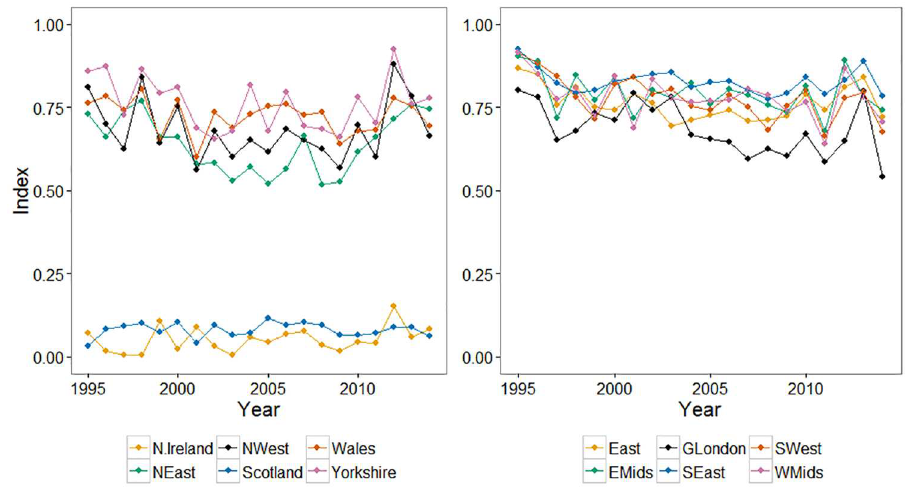
Fig 5. Illustrative regional occupancy indices for Large Skipper. Confidenceintervalsare suppressedfor clarity. The indicesare presentedacross two plots for clarity, and are looselygroupedfor northernand